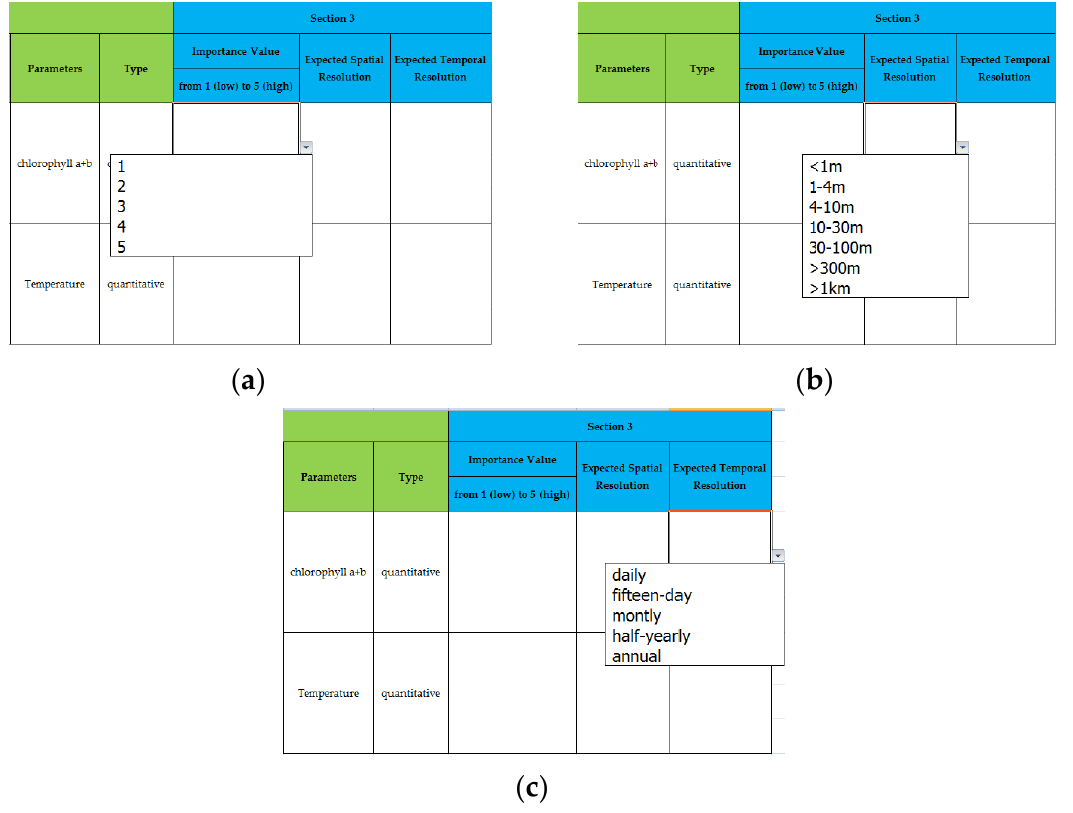
Figure 3. Example of how user communities were questioned about the priority value ( a ) and expected spatial resolution ( b ) and temporal resolution ( c ).